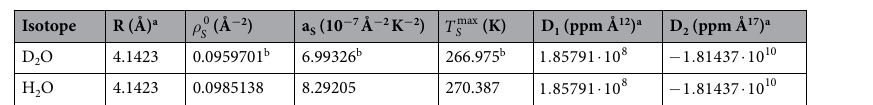
Table 3. Parameters for the cavity model fit to experiment. a Common fitted parameters for both solvent isotopes. b Parameters fixed to the fit to the MD